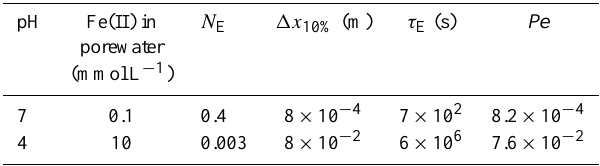
Table 3. Estimates of relevant parameters and non-dimensional numbers at pH 4 and